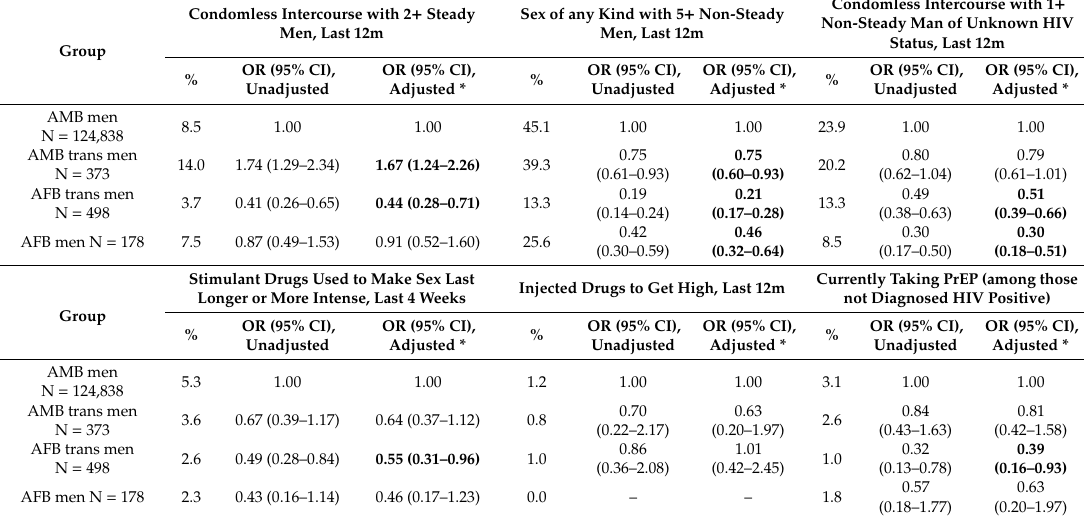
Table 3. Risk and precaution behaviors across four sex-assigned-at-birth / current-gender-identity subgroups of